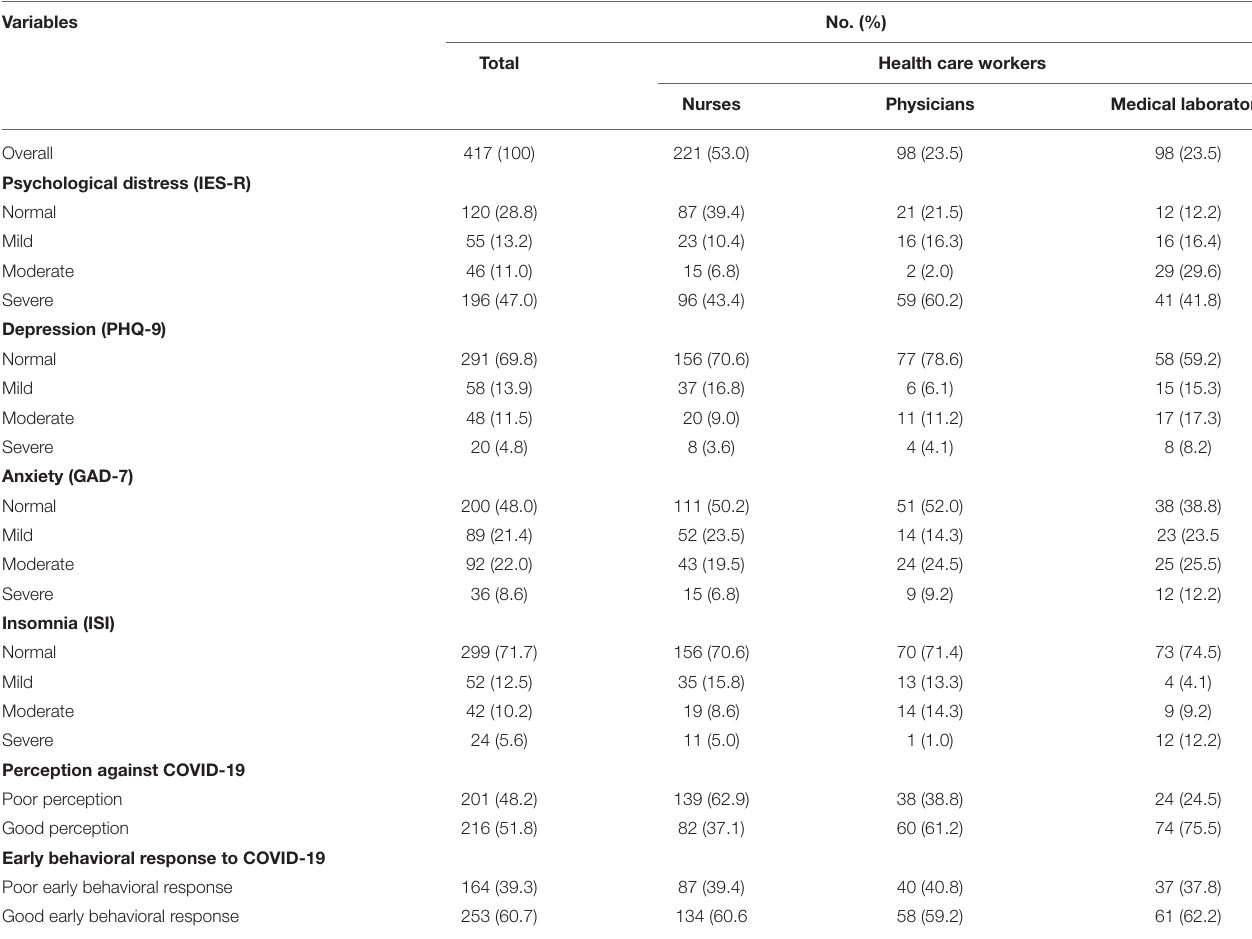
TABLE 4 | The prevalence of psychological distress, depression, anxiety, and insomnia during the COVID-19 pandemic among HCWs in North Shoa Zone health care facilities, Oromiya region, July 2020 ( n = 417).